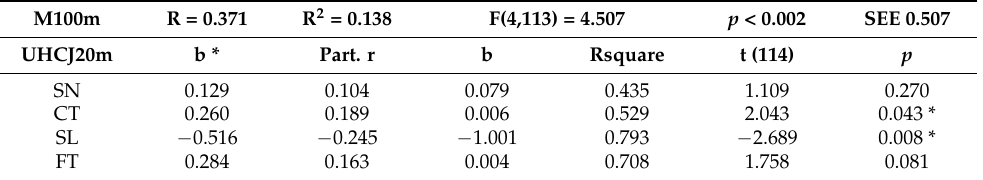
Table 4. Results of stepwise forward regression analysis of the set of kinematic parameters of the UHCJ20m test and results in the M100m test.